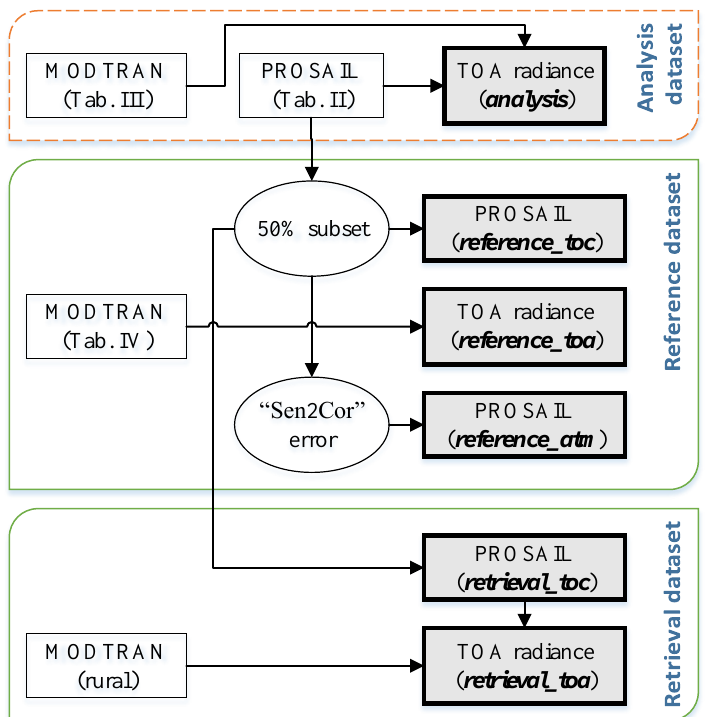
Figure 3. Schematic representation of synthetic datasets based on PROSAIL and MODTRAN simulations. The red-dashed and green lines identify the datasets used respectively for Global Sensitivity Analysis and Biophysical parameters retrieval. Table 2. Range of vegetation input variables for the PROSAIL LUTs according to Latin